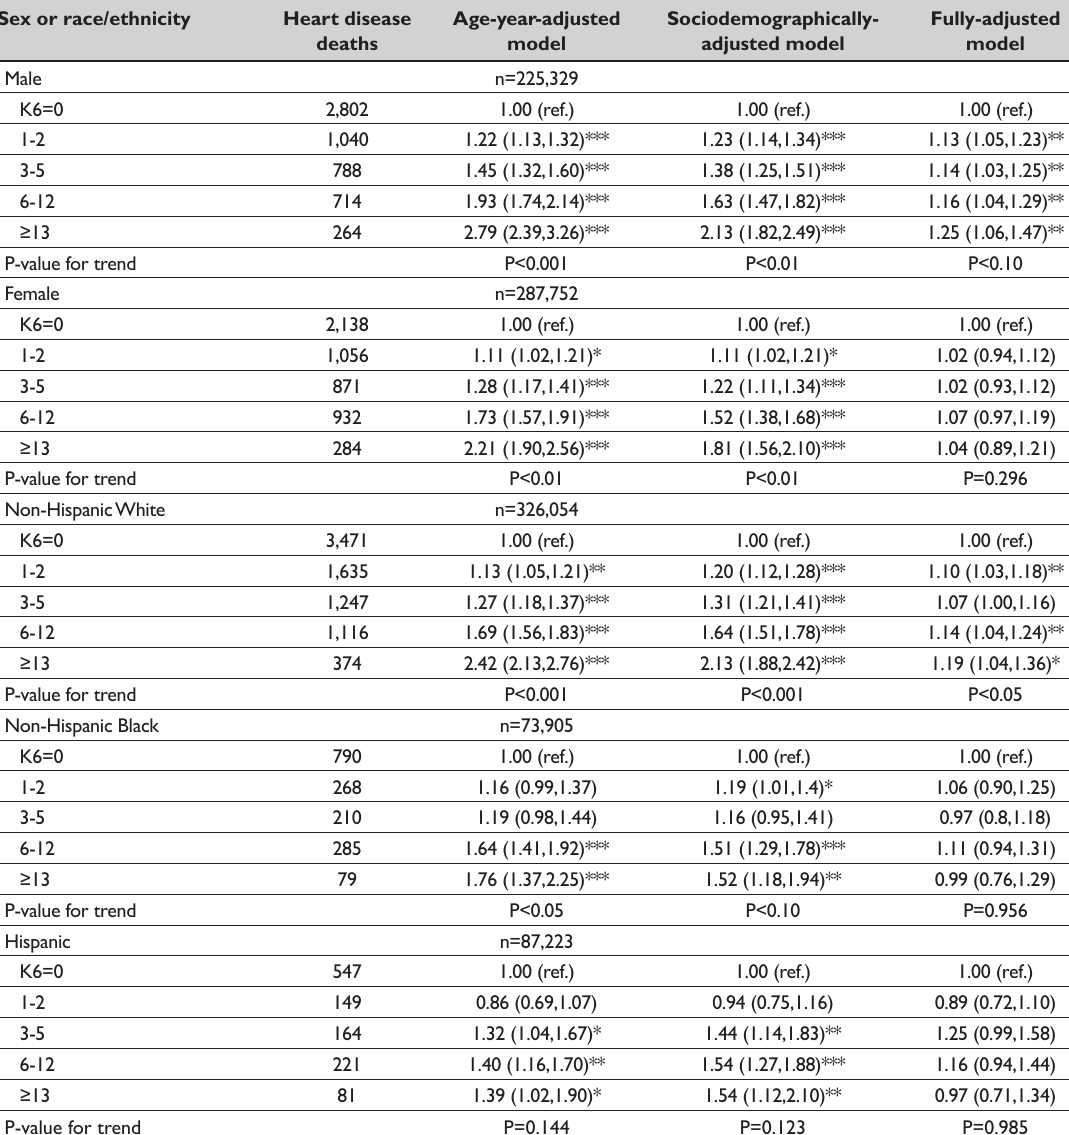
Table 4: Sex and racial/ethnic-specific age-year-adjusted and covariate-adjusted hazard ratios (HRs) of heart disease mortality by psychological distress levels (K6) among US adults aged ≥18 years,